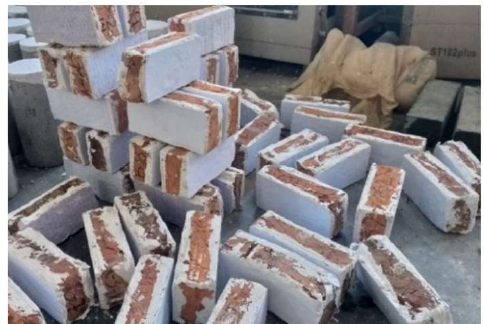
Figure 4. Capped bricks.